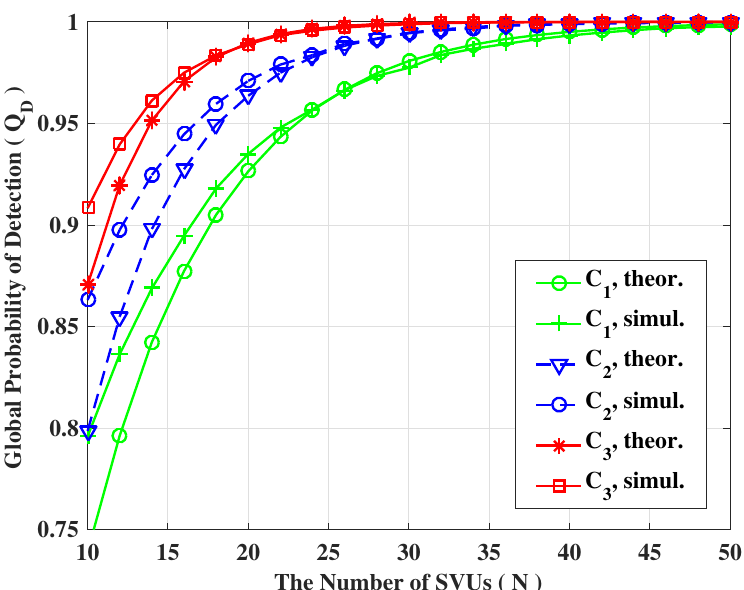
Figure 8. The detection probability of hard fusion scheme for various number of SVUs ( K = 50, η 0 = − 8 dB, Q = 0.1, C = 2 : f d T s F